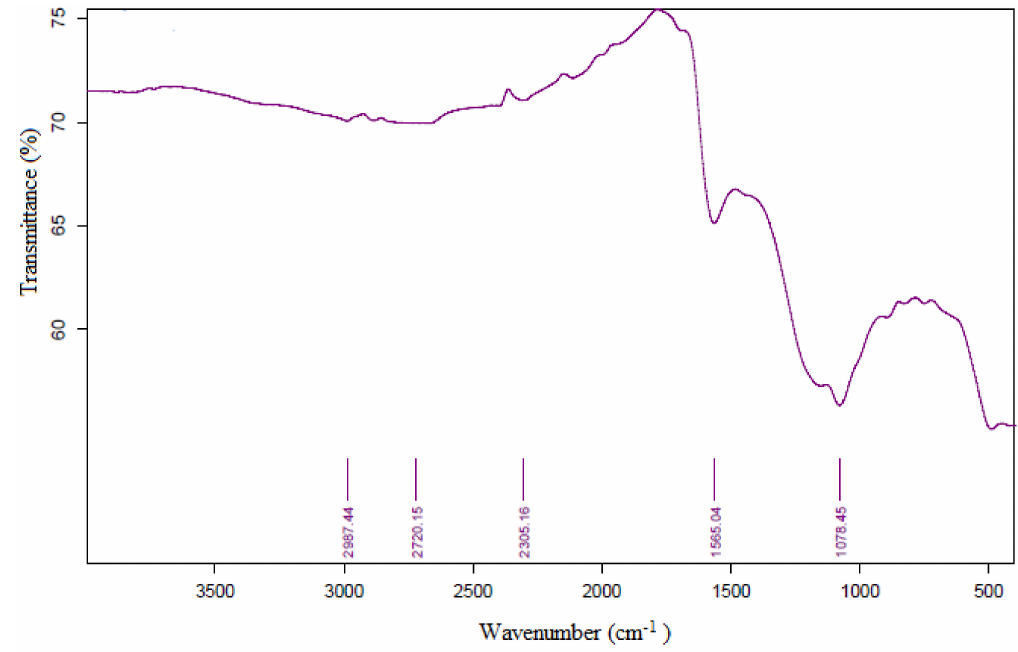
Figure 6. FT-IR analysis of activated carbon.